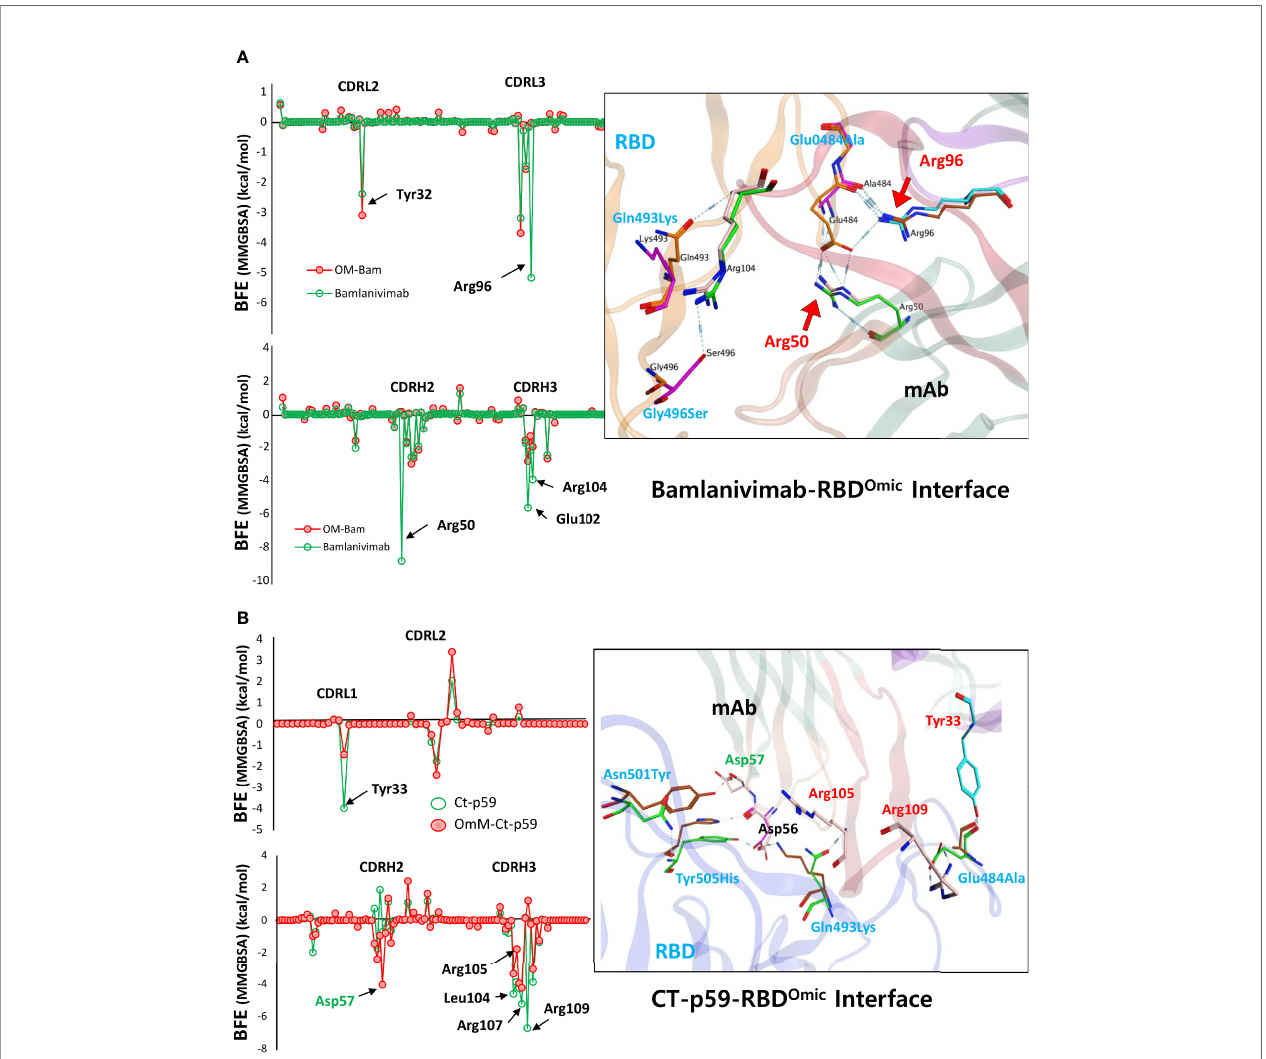
FIGURE 4 | Per-residue changes in the binding af fi nity of RBD – mAbs were monitored and the hotspots on CDRs of (A) bamlanivimab and (B) CT-p59 are labeled. The change in the hydrogen bond network of the selected hotspots is shown at the